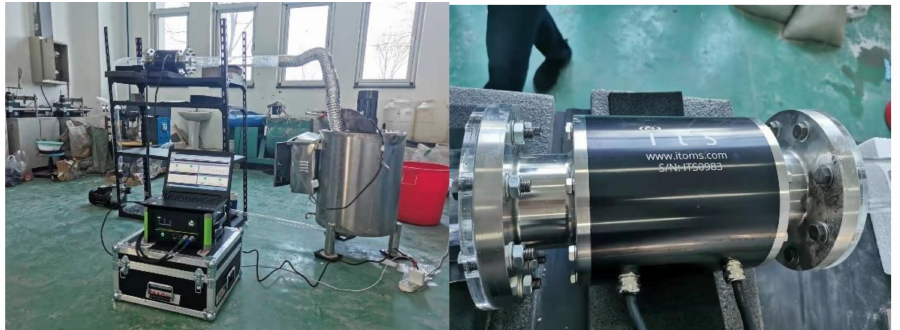
Figure 6. Experimental